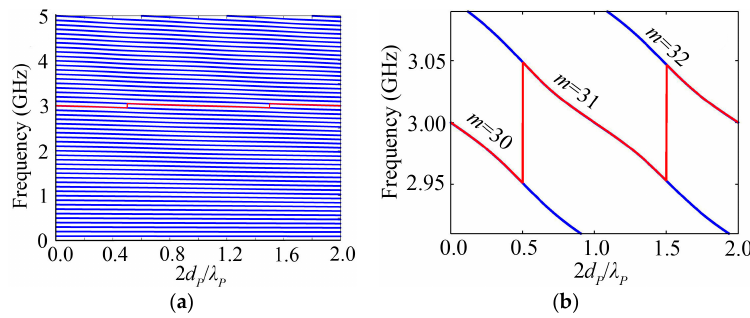
Figure 5. The HBAR consisting of ZnO/Sapphire 55.78 μ m ; ( a ) The variation curve of the resonance frequency with the piezoelectric film thickness; ( b ) The partial enlarged drawing of Figure 5a.